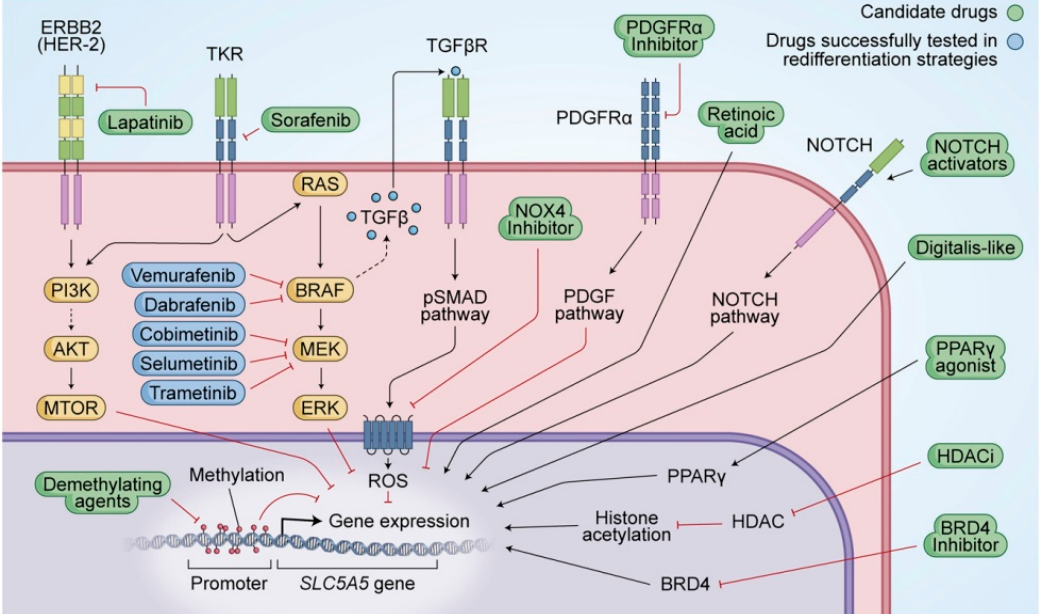
Figure 4. Current and future activators of NIS symporter in treating radioiodine refractory disease: MAPK (mitogen-activated protein kinase) (RAS/RAF/MEK) and Phosphoinositide 3-kinases (PI3K/protein kinase B, AKT/mechanistic target of rapamycin (mTOR)) are key signaling pathways in thyroid cancer pathogenesis. Signaling cascades can be blocked by new targeted therapies. The crosstalk between MAPK and PI3K through RAS represents a tumor escape mechanism from known multi-kinase inhibitors and selective inhibitors of BRAF. The PI3K-AKT pathway activation leads to suppression of NIS glycosylation and surface translocation. The inhibition of mTOR promotes redifferentiation of thyroid cancer cells by upregulation of NIS mRNA and protein expression through increased transcription of thyroid transcription factor 1 (TTF1). Another important positive regulator of NIS expression is Phosphatase and tensin homolog (PTEN). TSH signals through the heterotrimeric G-protein complex and through activation of cyclic adenosine monophosphate (cAMP) increase transcription of the NIS gene. Aberrant activation of the MAPK signaling pathway inhibits Phosphatidylinositol glycan anchor biosynthesis class U protein (PIGU) expression and NIS basolateral transport. Pituitary tumor-transforming gene 1 (PTTG1) and pituitary binding factor (PBF) overexpression results in decreased NIS levels in thyroid cancer. Genetic and epigenetic alterations in the RTK/BRAF/MAPK/ERK and PI3K-AKT-mTOR pathways by acquired point mutations, chromosomal rearrangement, or aberrant gene methylation underlies the diminished NIS signaling central to RAI refractoriness. First, BRAF activates TGF β -transforming growth factor β )/Smad3 signaling, which directly impairs the ability of the thyroid-specific transcription factor paired box gene 8 (PAX8) to bind the NIS promoter in follicular cells. Second, BRAF epigenetically regulates NIS by driving histone deacetylation of the H3 and H4 lysine residues of the NIS promoter, directly preventing its transcription [68]. Copyright ID 1188004-1, Bioscientifica Limited.